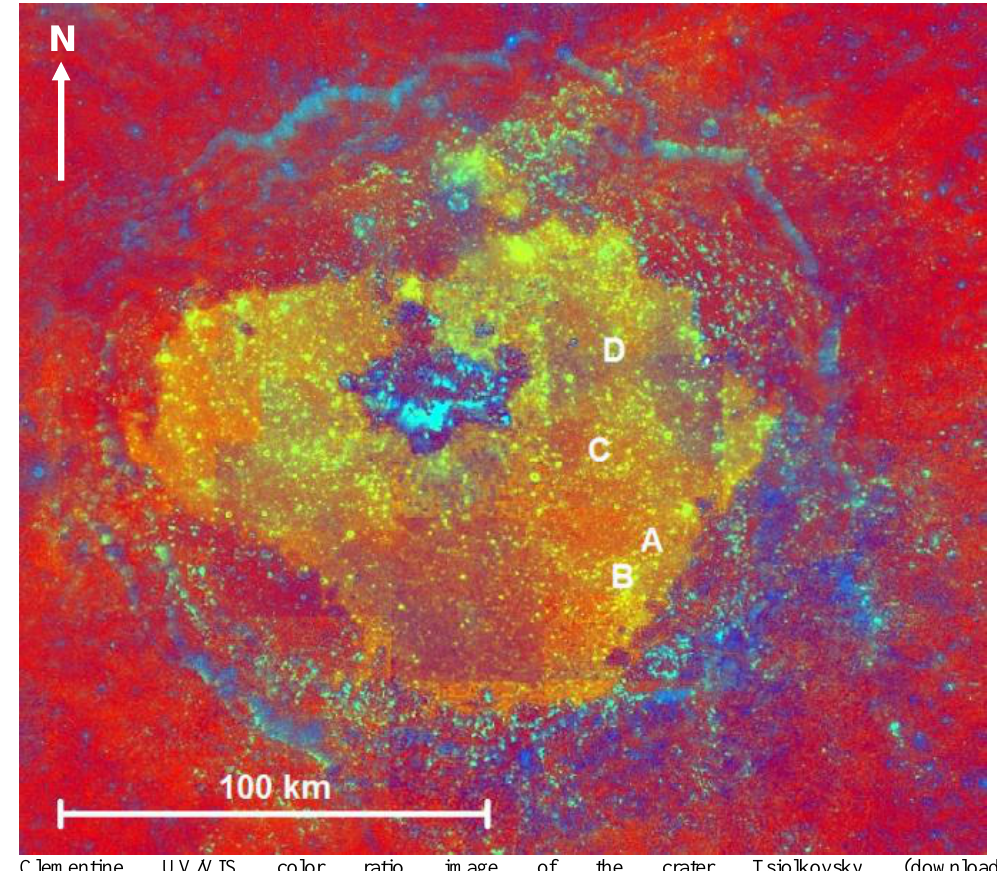
Figure 6. Clementine UV/VIS color ratio image of the crater Tsiolkovsky (downloaded from http://www.mapaplanet.org/explorer/moon.html, definition of color channels according to Pieters et al.,